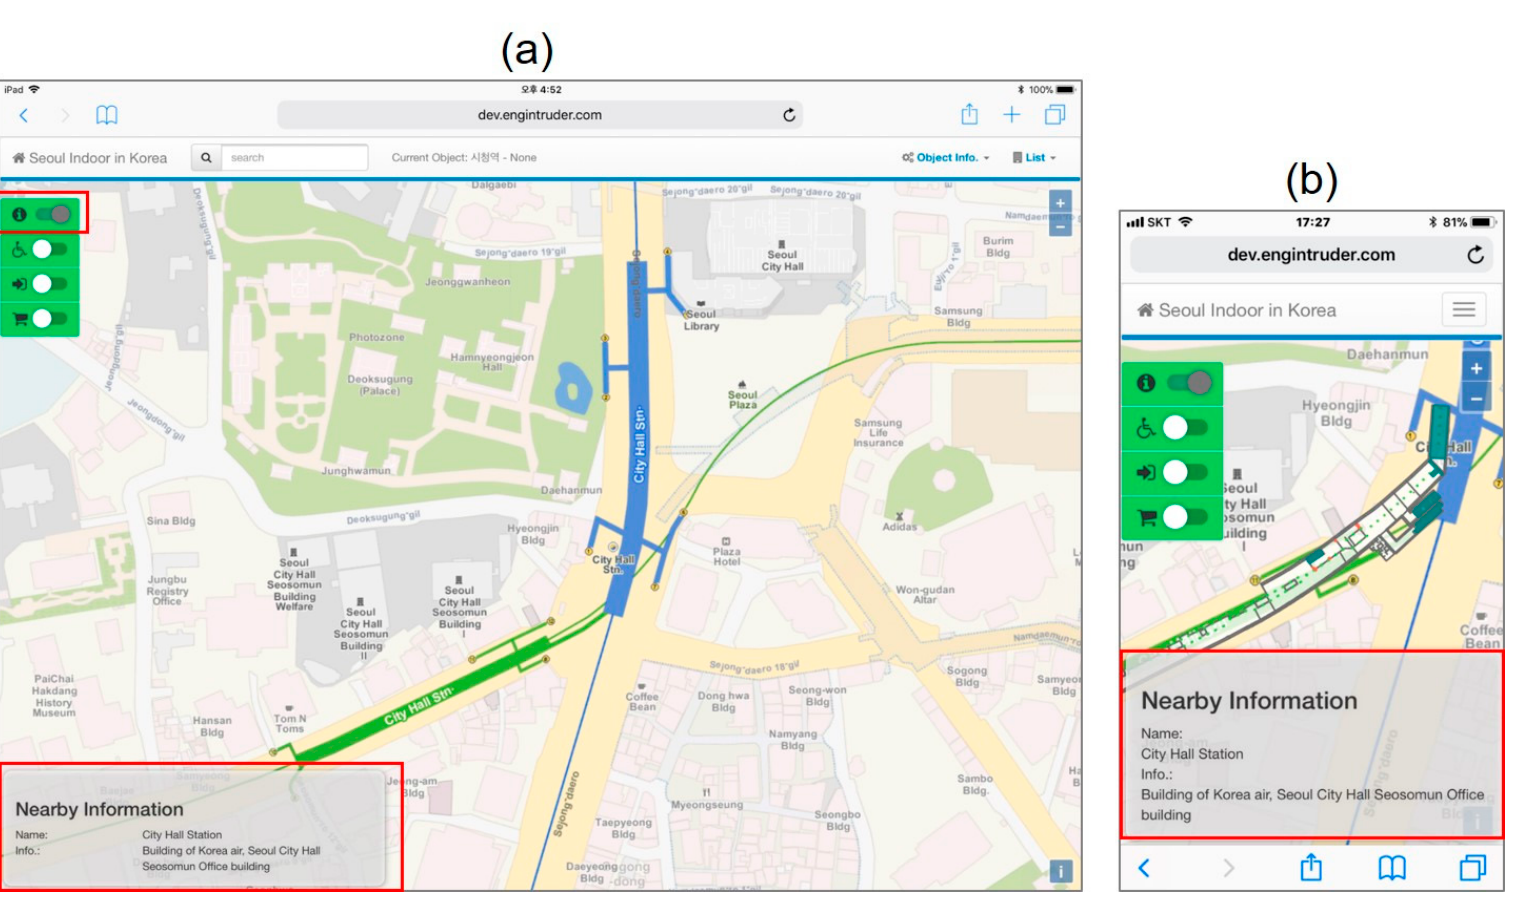
Figure 12. Visualization results of detailed information about a nearby building on ( a ) iPad mini and ( b ) iPhone.